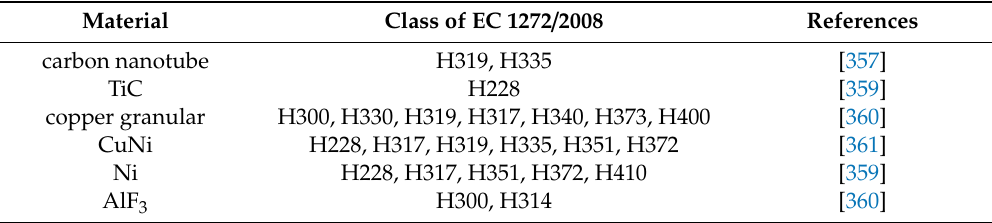
Table 14. Hazard statements of carbon nanotube, TiC, granular copper, CuNi, Ni, and AlF 3